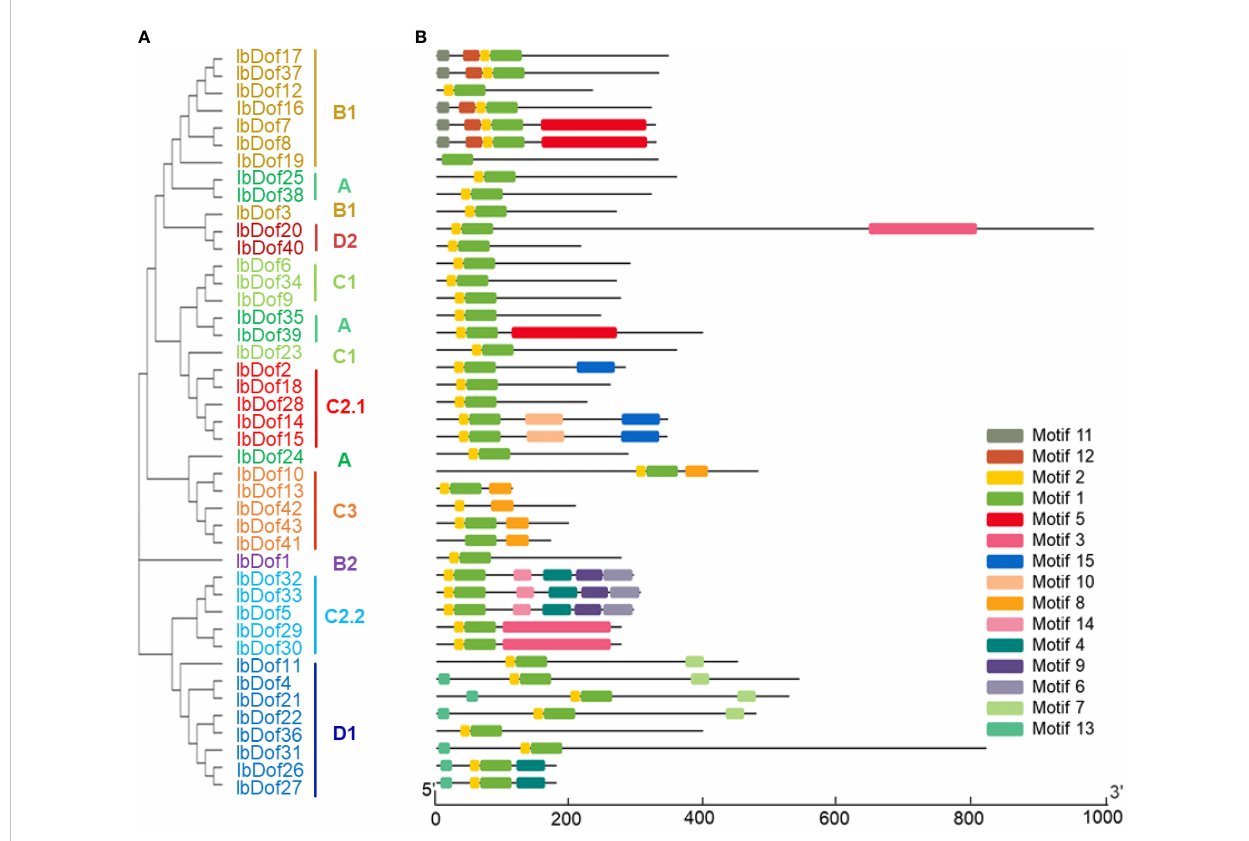
FIGURE 4 Phylogenetic relationships and conserved motif compositions in sweetpotato IbDofs. (A) The phylogenetic tree of 43 IbDofs was constructed by MEGA X based on the consistent parameters used in Figure 2. (B) Conserved motif compositions detected by MEME analysis within sweetpotato IbDofs. Boxes of different colors present different motifs, and the yellow and green boxes contained in IbDofs represent the Dof domain. The length of IbDofs can be estimated by the scale at the bottom.